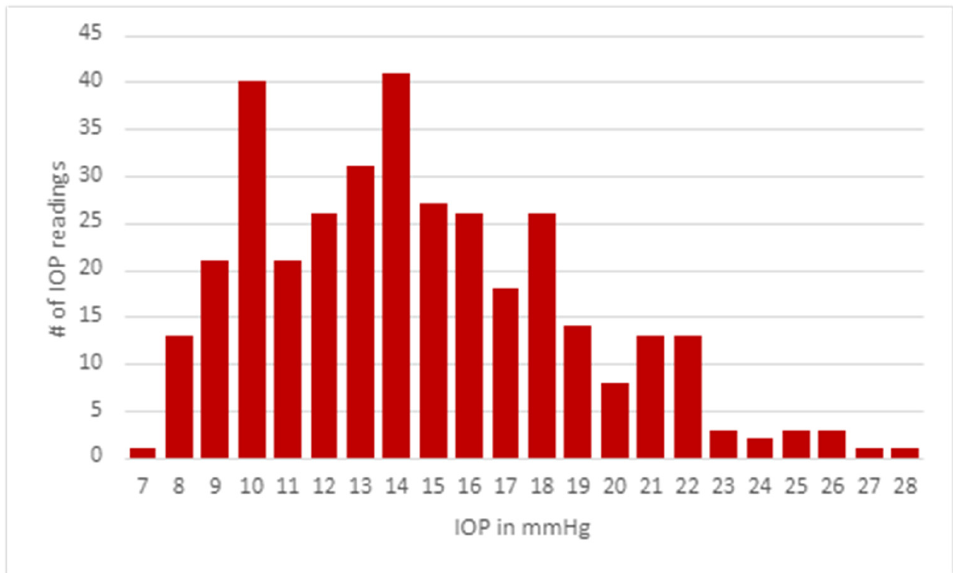
Figure 5. Distribution of IOP measurements of participants.